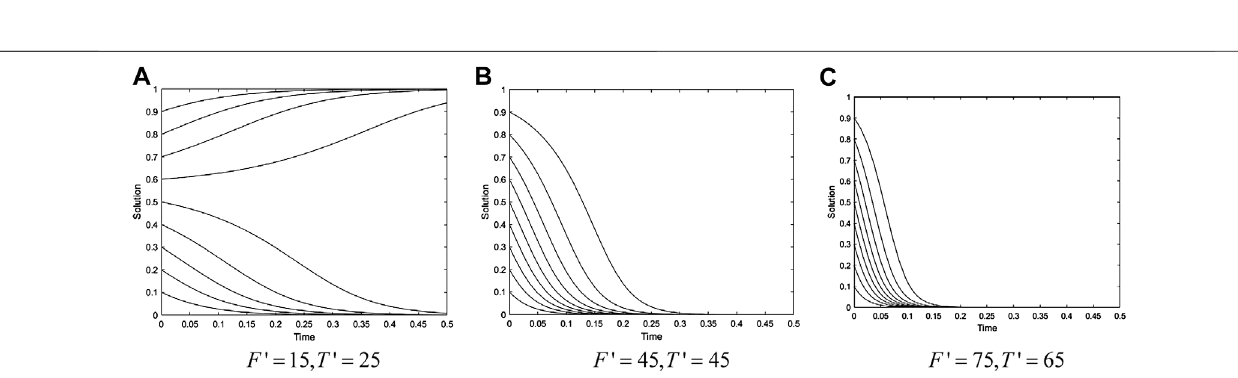
Frontiers in Energy Research |